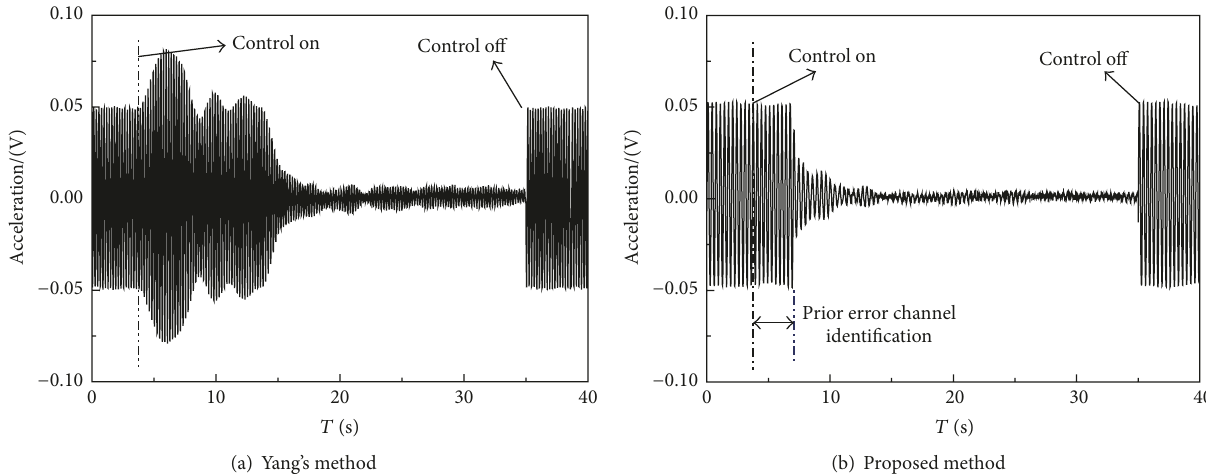
Figure 16: Performance comparison between Yang’s method and the proposed method.